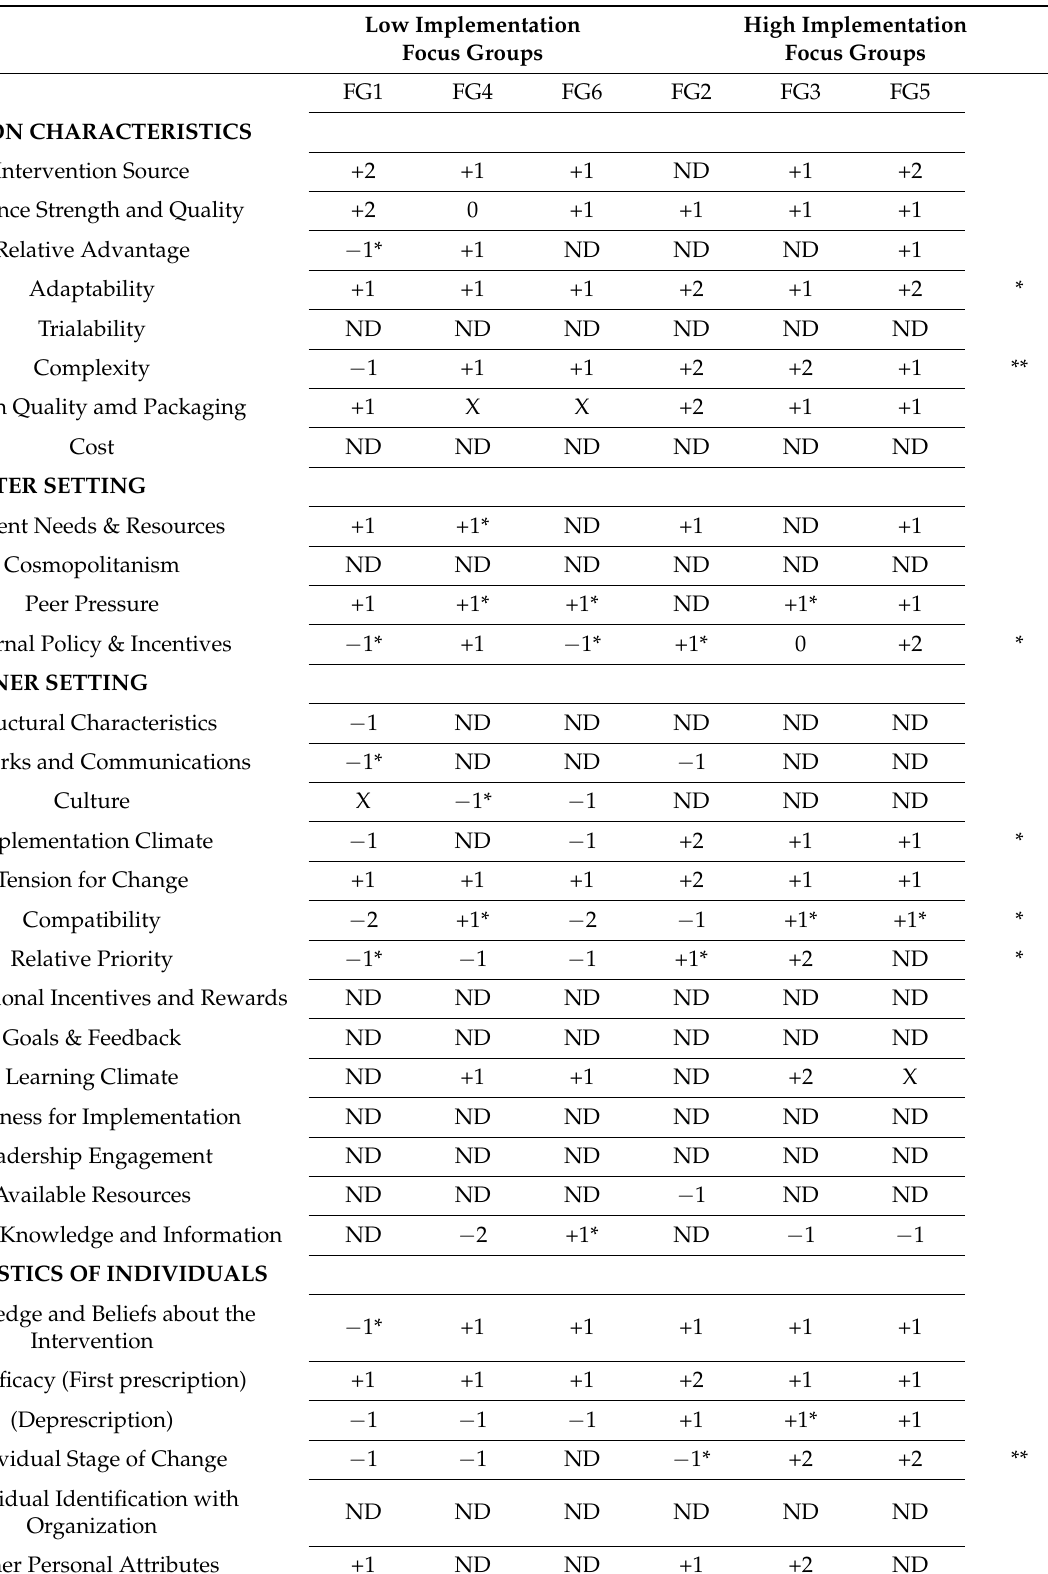
Table 2. Ratings assigned to CFIR construct by